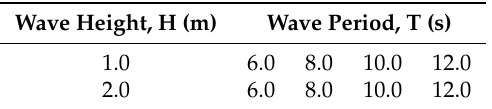
Table 1. Test matrix of regular wave